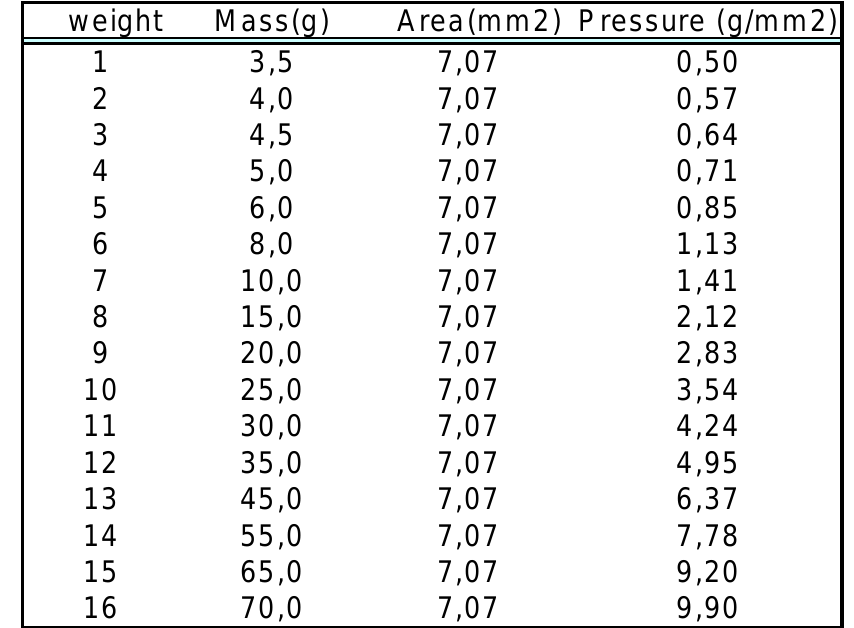
TABLE 1 - Loads and corresponding pressures used to quantify the threshold of sensitivity to the